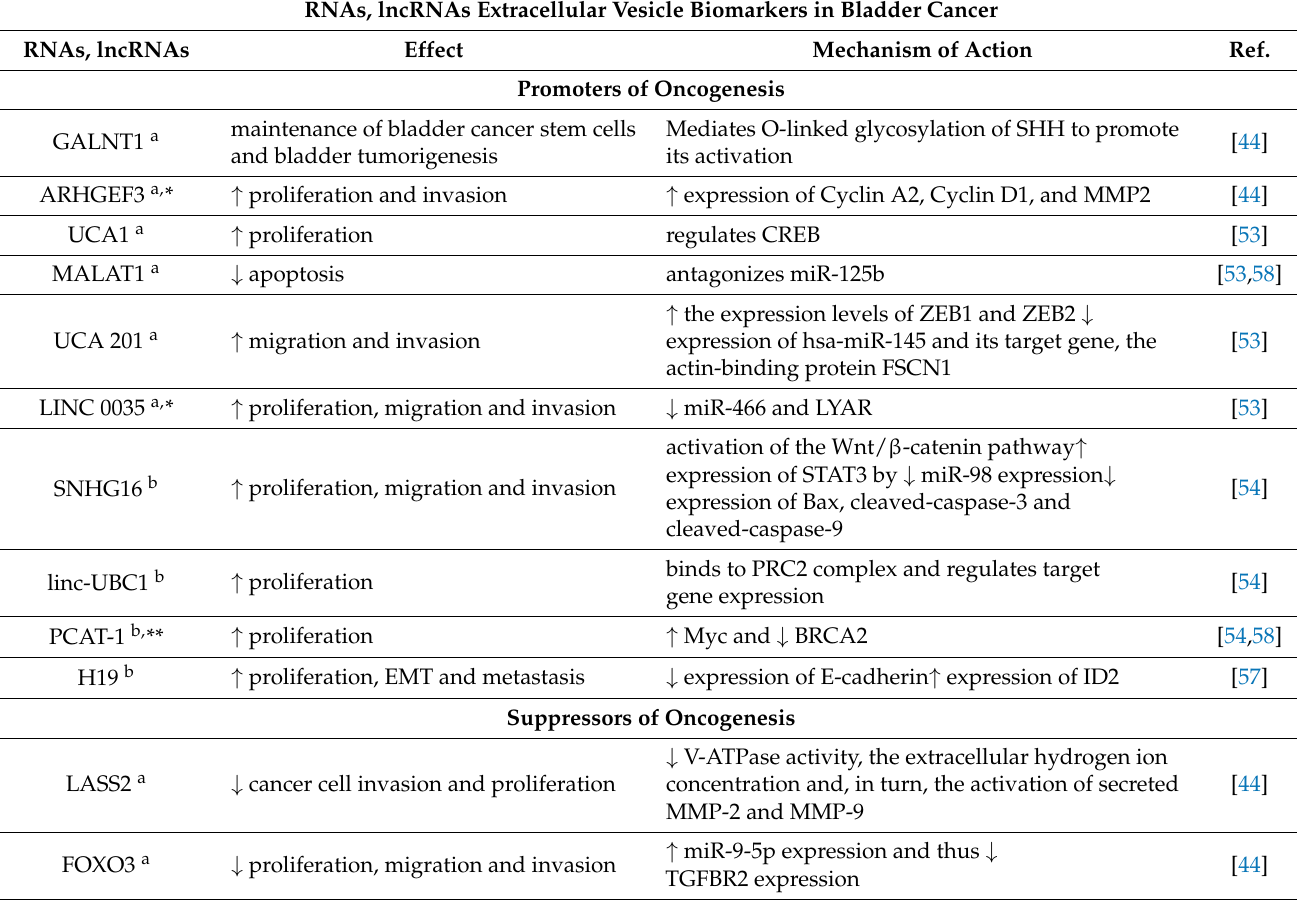
Table 3. Molecular pathways of EV RNA and LncRNA biomarkers in bladder cancer pathogenesis. RNAs, lncRNAs Extracellular Vesicle Biomarkers in Bladder Cancer RNAs,